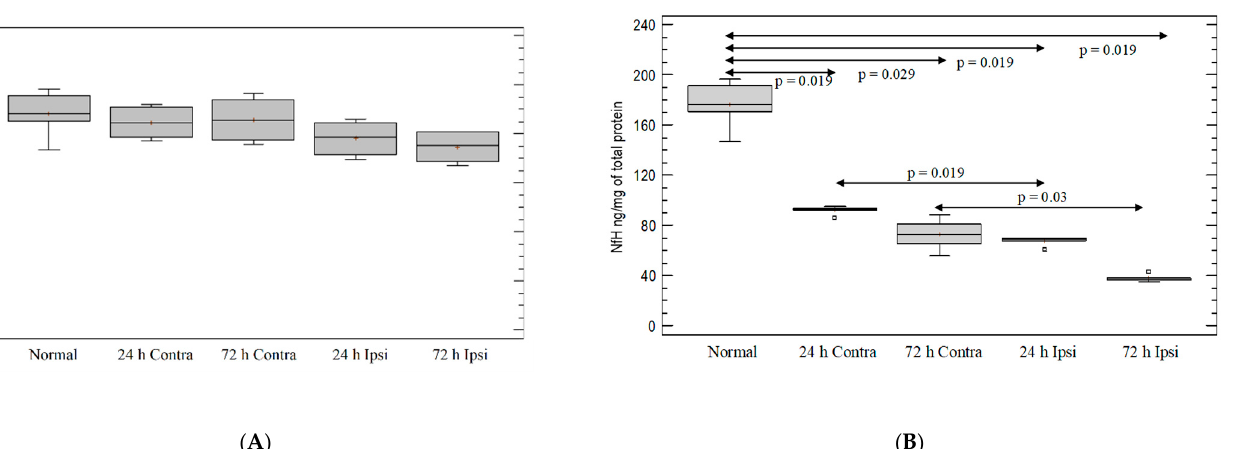
Figure 7. The level of phosphorylated neurofilaments in mouse brain after ( A ) PBS injection and ( B ) KA injection. Brains were collected 24 h and 72 h postinjection. Ipsi—ipsilateral hemisphere; Contra—contralateral hemisphere; Normal—control animals without any injection.